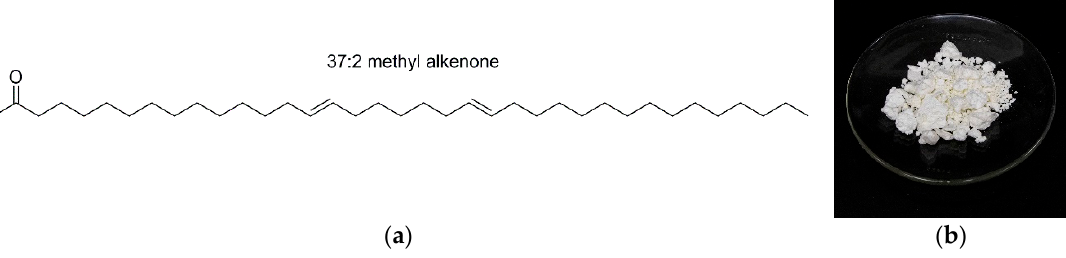
Figure 1. ( a ) Structure of a common alkenone, i.e., 37:2 methyl alkenone, isolated from Isochyrsis microalgae. Alkenones contain trans double bonds and a methyl or ethyl ketone; ( b ) Alkenones wax.